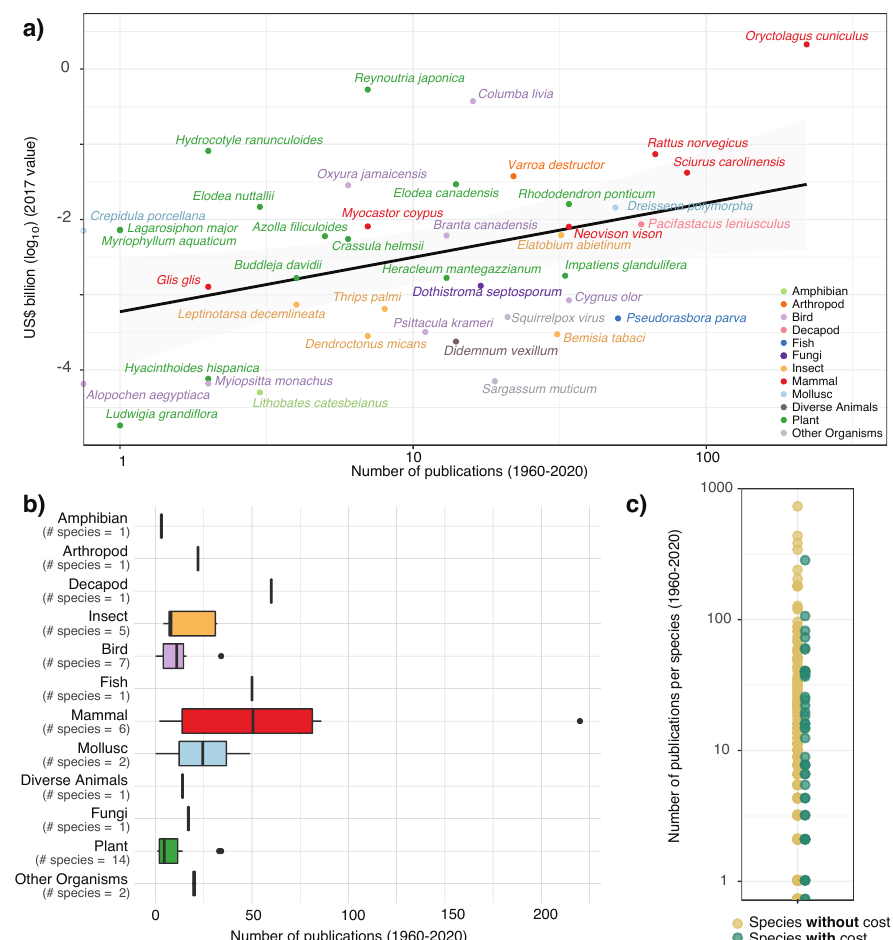
Figure 4. Per-species invasion costs and study efforts showing a the number of publications available in Web of Science for the period 1960–2020 for each species with InvaCost records against the total cost for each species in billion US$ (2017 value; log scale; shaded area is 95% confidence interval) b the distribu- 10 tion of the number of publications available in Web of Science for the period 1960–2020 for each species with invasion costs by organism group (“# species” refers to numbers of species in InvaCost within that group) and c distribution of publication numbers of invasive species with and without